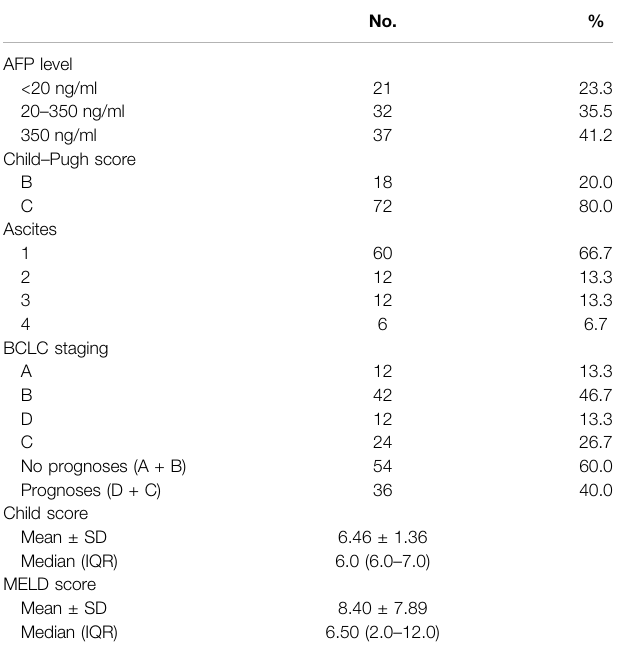
TABLE 3 | Distribution of the studied cases according to different parameters for the HCC group ( n =